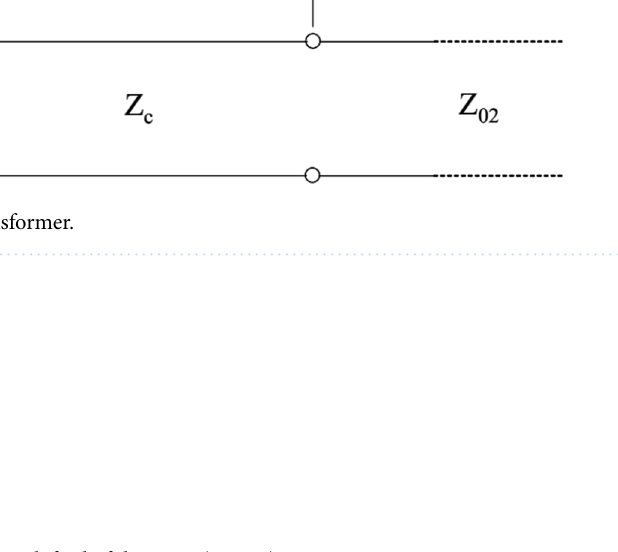
Table 4. Dimensions of the network feed of the array (in mm).